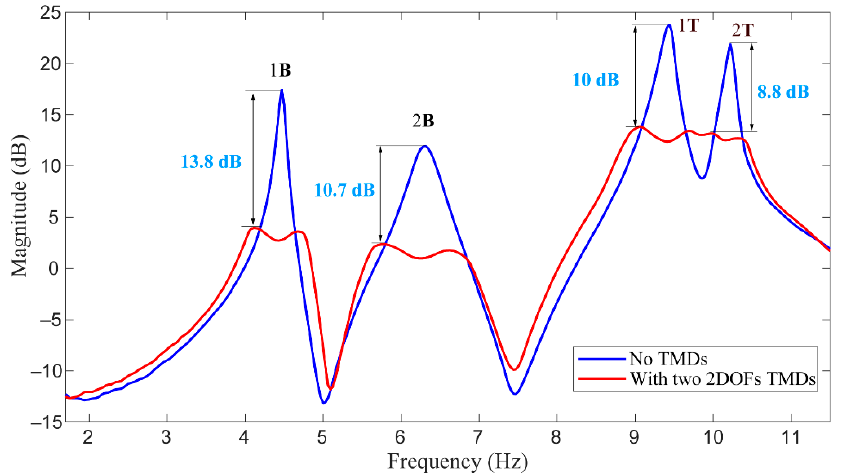
Figure 21. Experimental results: frequency response functions of the deck: blue line stands for without the TMDs; red line stands for with two TMDs of 2 DOF each, targeted for the damping of the mode pairs (2B,1T) and (1B,2T).